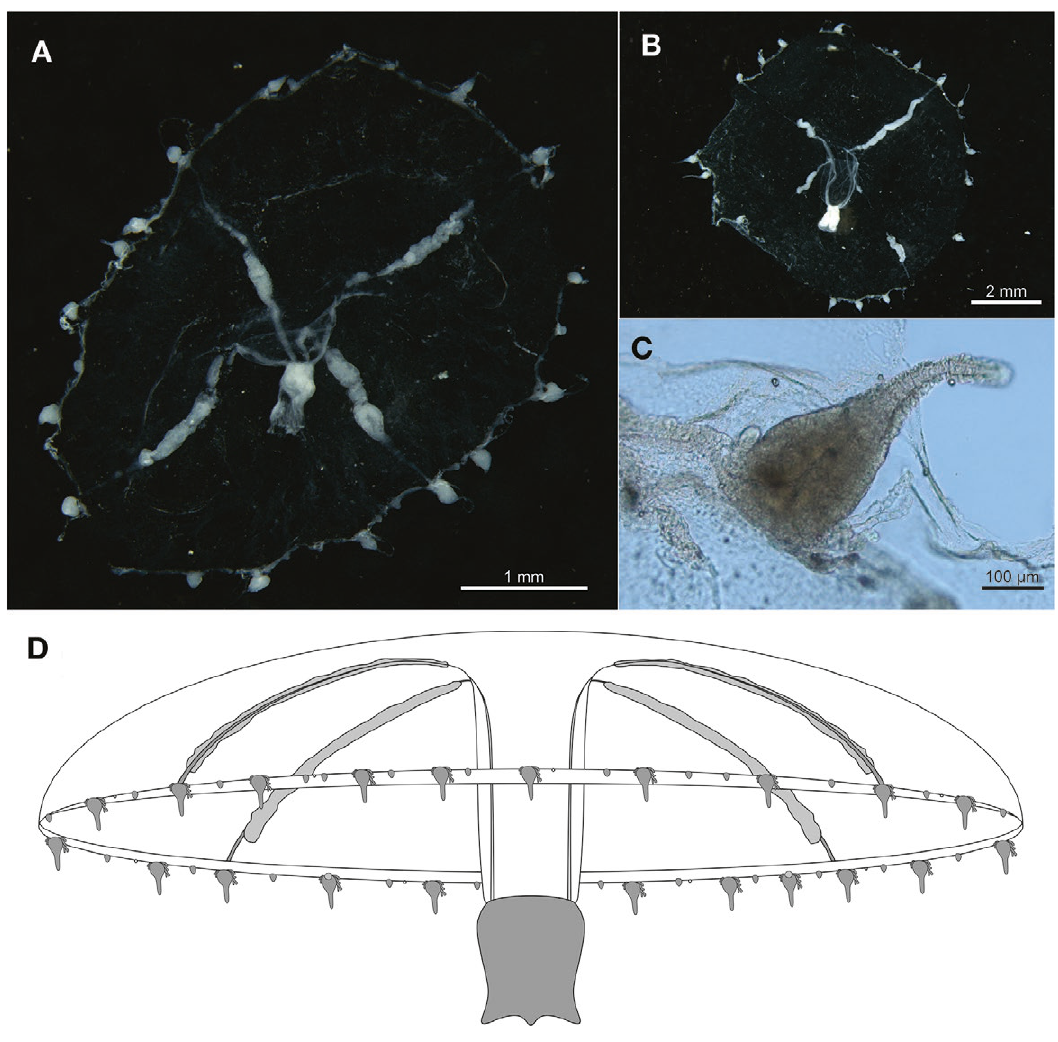
Fig. 2. – Eutima marajoara n. sp. A, oral view of the holotype; B, paratype; C, detail of a tentacular bulb with lateral cirri; D, schematic representation of adult specimen. Table 3. – Summary and coefficients (a, b) of linear regression relat- ing umbrella diameter and mean number of marginal structures